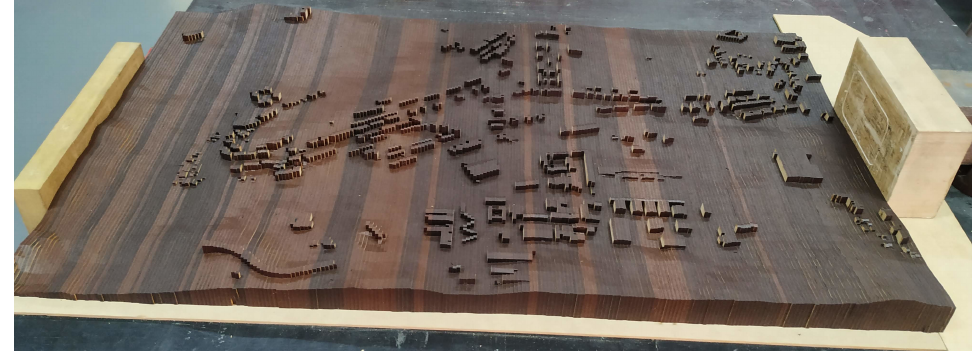
Figure 4. Physical model, after the pieces of wood were cut and put